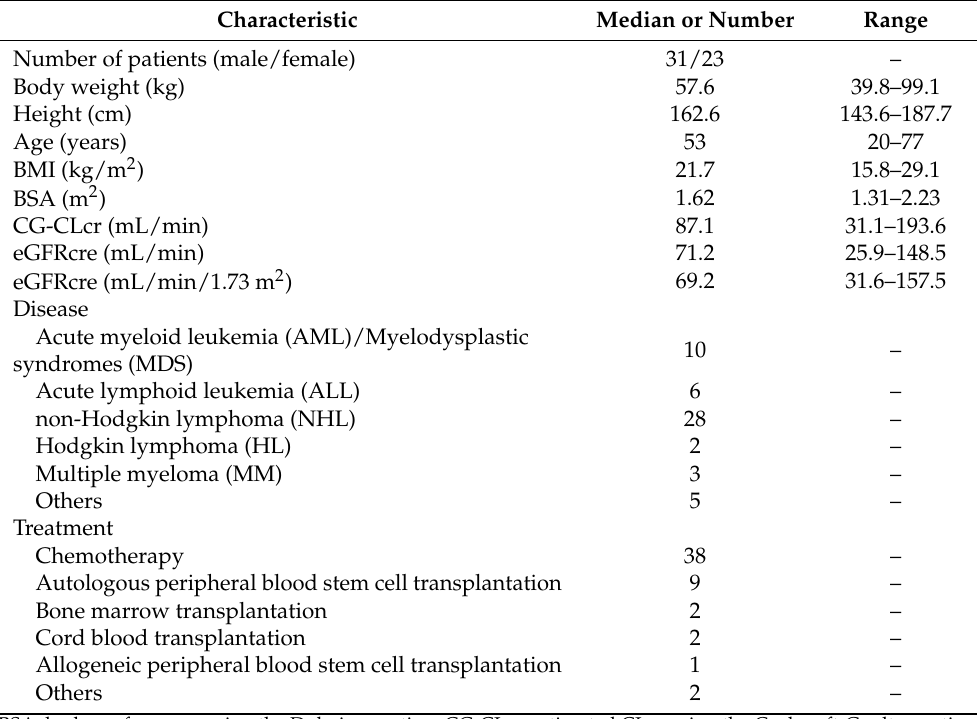
Table 1. Demographic and clinical characteristics of the